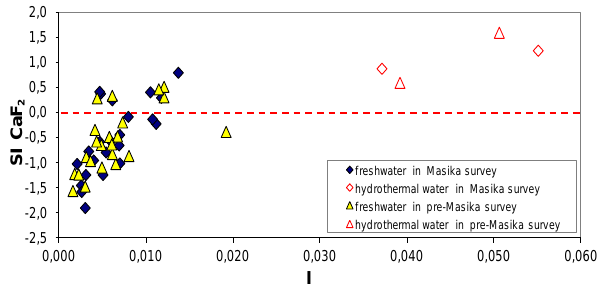
Fig. 14. Plot of fluorite saturation index vs. ionic strength.